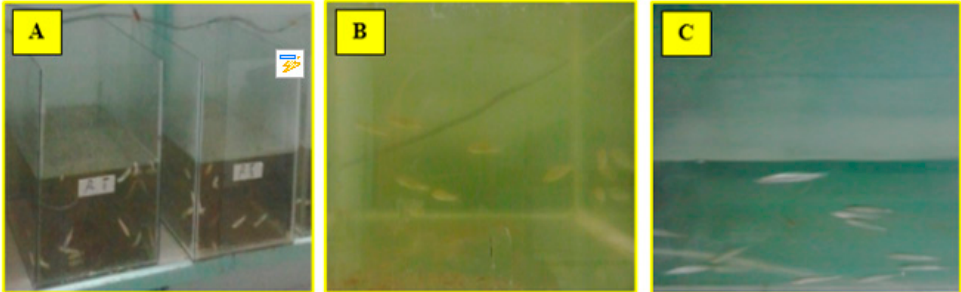
Figure 6. Variation in behavioural response of C. idella on exposure to untreated tannery effluent at 50% dilution showing irregular swimming and zig-zag movements ( A ), and normal movements and swimming behaviour in treated tannery effluent at the same dilution level ( B ), and in tap water set as control ( C ).